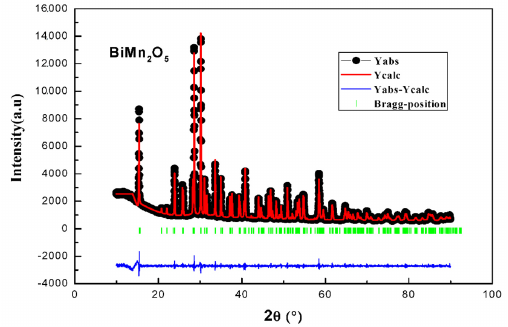
Figure 1. XRD pattern of BiMn 2 O